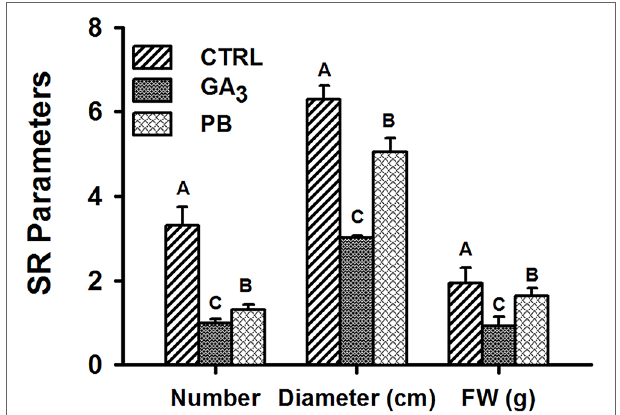
FiGURe 3 | Effect of GA 3 application on sweetpotato “ Georgia Jet ” storage- root characteristics. Storage-root (SR) number, average diameter and fresh weight (FW) per plant were recorded at five weeks (5W) after planting. Bars represent mean of 16 (for SR number and fresh weight; FW) or four (for SR diameter) independent biological replicates (plants) ± SE. Significance analysis was performed by using student’s t-test ( P ≤ 0.05) , where unlike letters represent significant differences between treatments within a sampling group. CTRL, Control (treated with water); GA 3 , application of 50 ppm gibberellic acid 3 for two weeks; PB, application of 5 ppm paclobutrazol for two weeks.